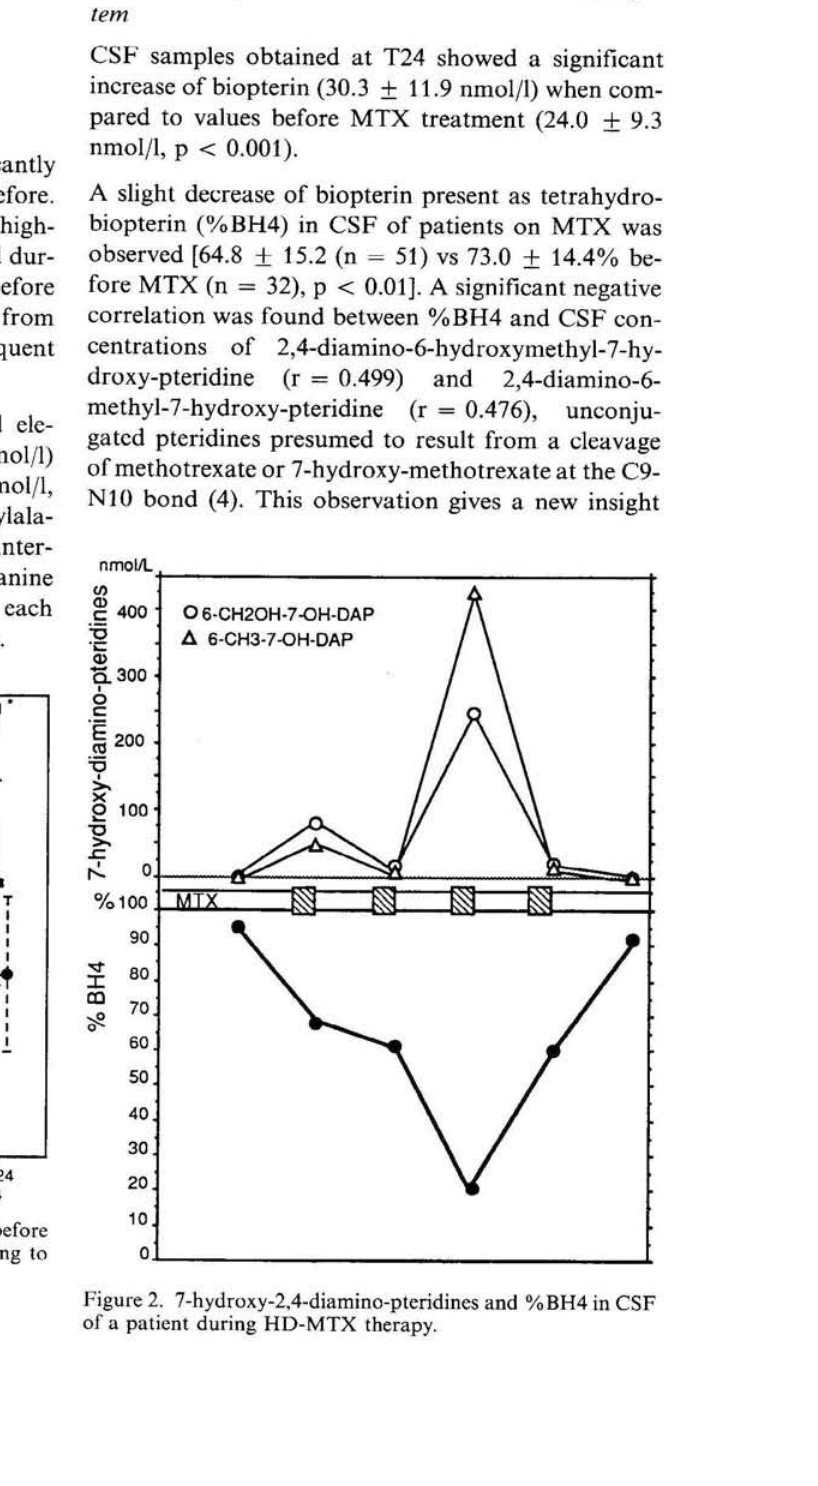
Figure 1. Serum neopterin and biopterin concentrations before (TO) and at the end of the MTX infusion (T24) according to cycle number * Student's test ** ns, not significant at ρ = 0.01